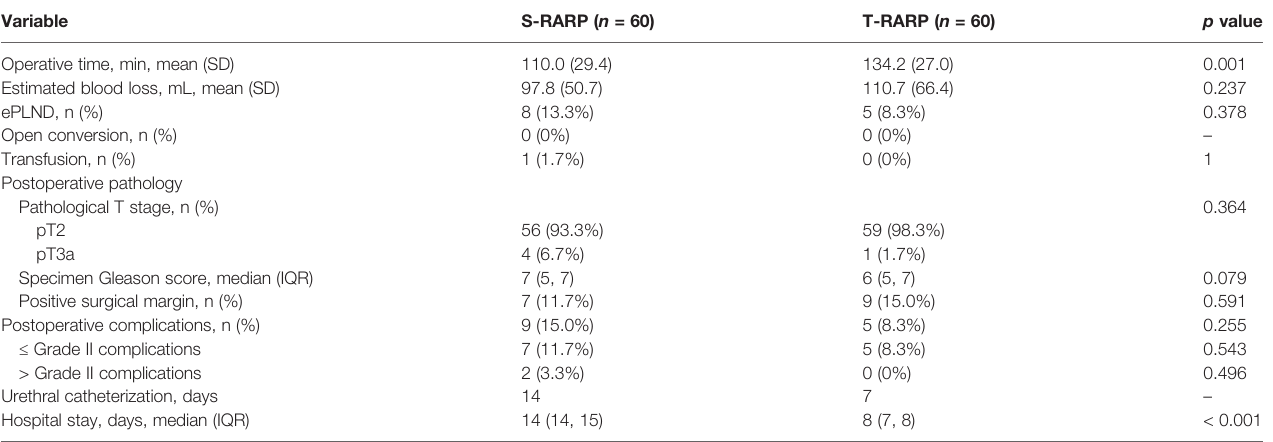
TABLE 2 | Perioperative outcomes for S-RARP and T-RARP after propensity score matching. Variable Operative time, min, mean